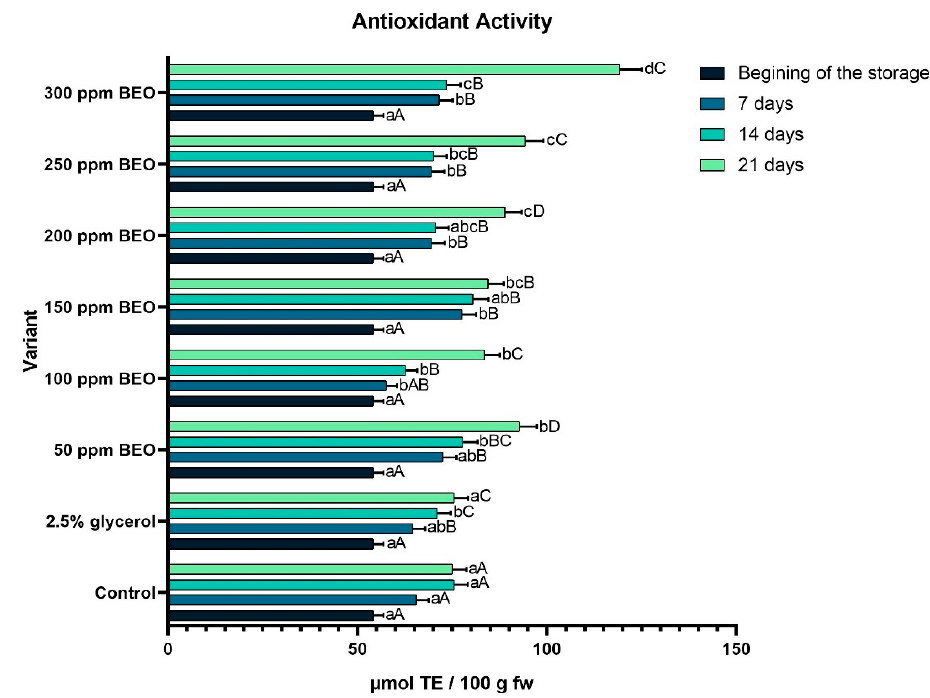
Figure 6. Effects of applied treatments on the antioxidant activity ( µ mol TE/100 g fw) during storage for 21 days at 8 ± 1 ◦ C. Bars for the same sampling time followed by different lowercase letters are significantly different based on the least significant difference (LSD) test ( p < 0.05). Bars for the same treatment during storage time followed by different uppercase letters are significantly different based on the least significant difference (LSD) test ( p < 0.05).